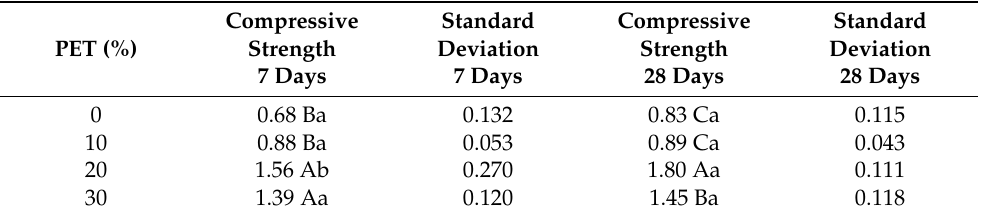
Table 4. Compressive strength of samples at 7 and 28